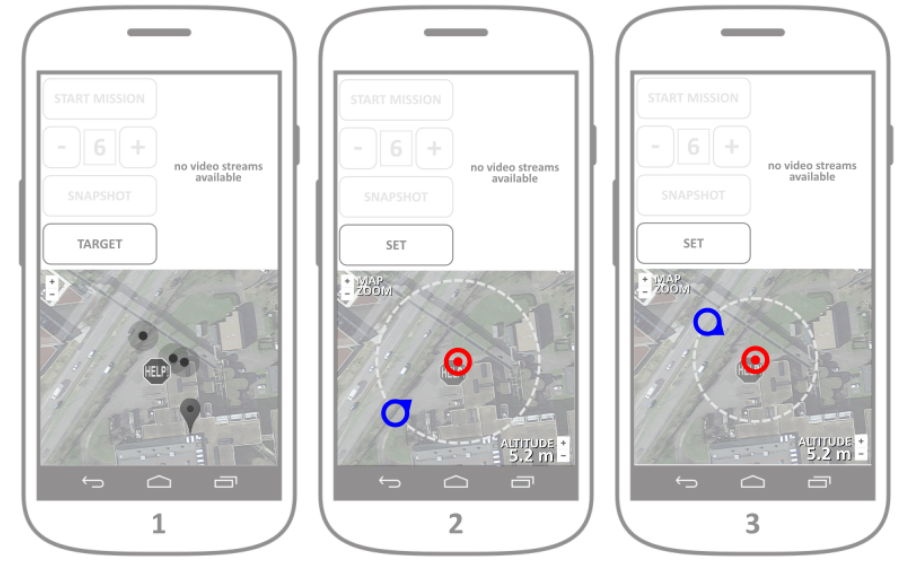
Figure 8. Fleet control